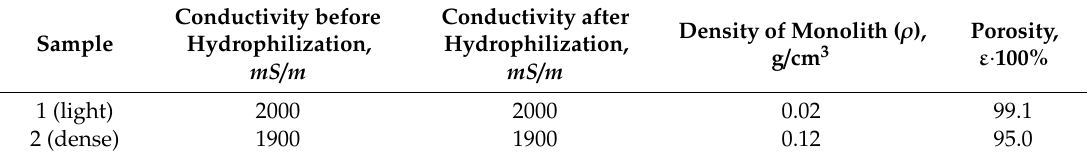
Table 1. Some primary properties of composite aerogel